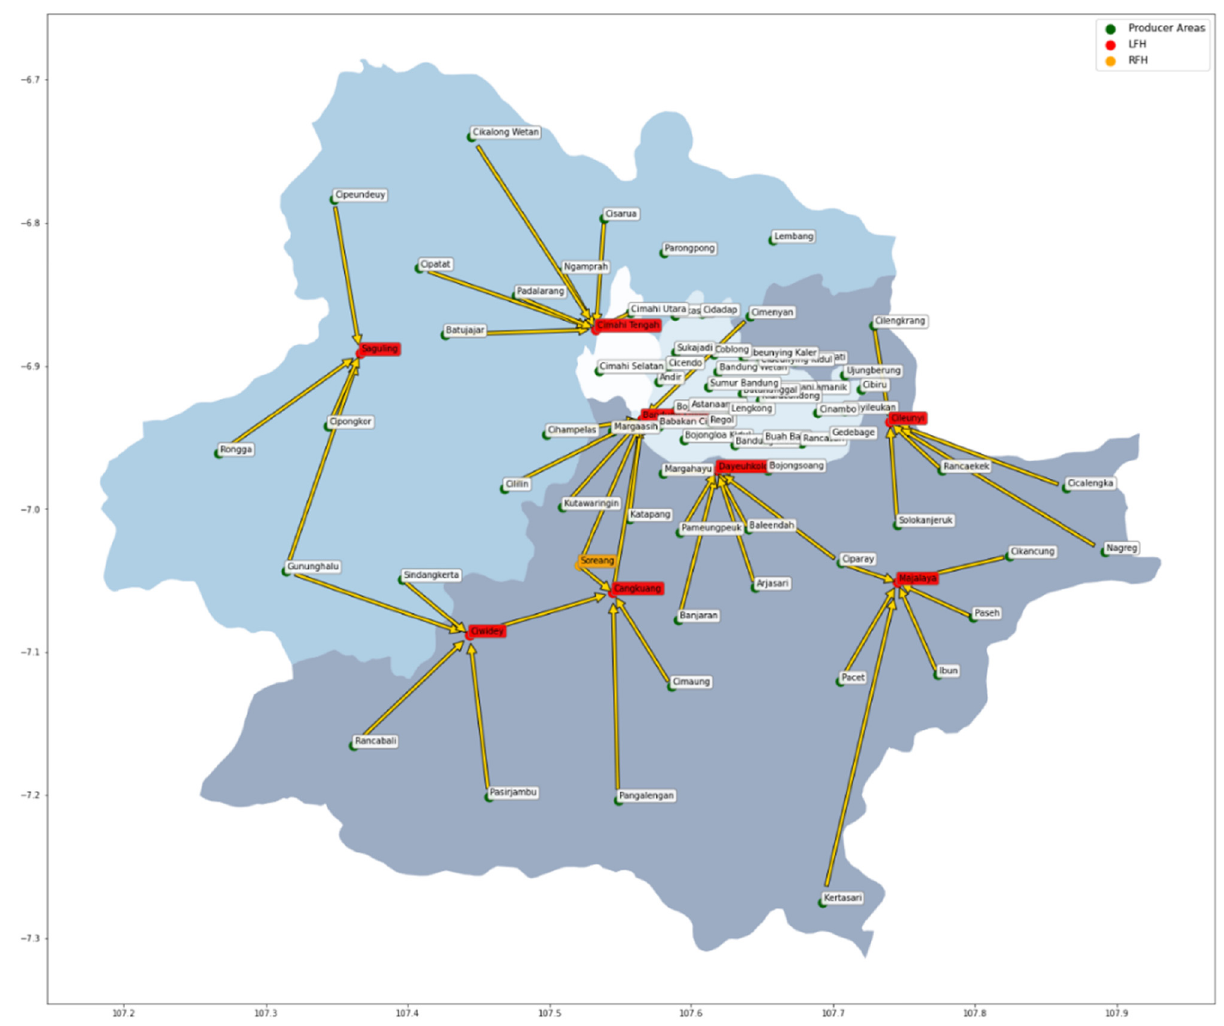
Figure 3: Food network from producer and regional food hub to local food